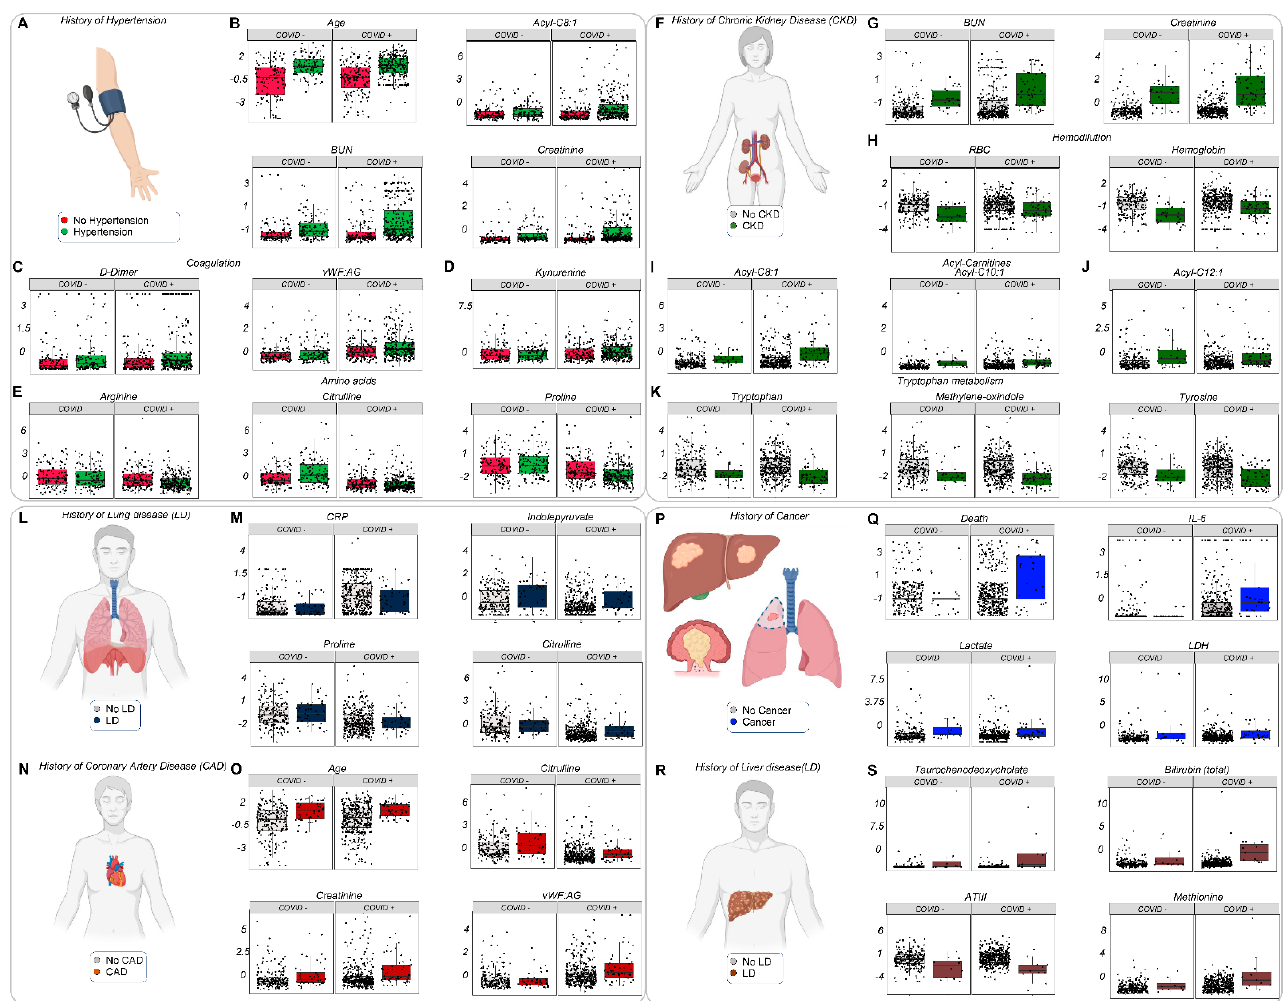
Figure 6. Clinical complications and metabolic/clinical markers. Hospitalized patients, with and without COVID-19, were divided into subgroups depending on clinical complications (e.g., stroke, deep vein thrombosis) and/or interventions (e.g., ventilators, hemodialysis). Mechanical ventilation ( A – E ), stroke ( F – J ), DVT ( K – N ), and hemodialysis (with or without coagulopathy; O – R ) in both COVID-19 patients and controls. All metabolites shown in this figure as dot plots are signif- icant by two-way ANOVA (FDR < 0.05).